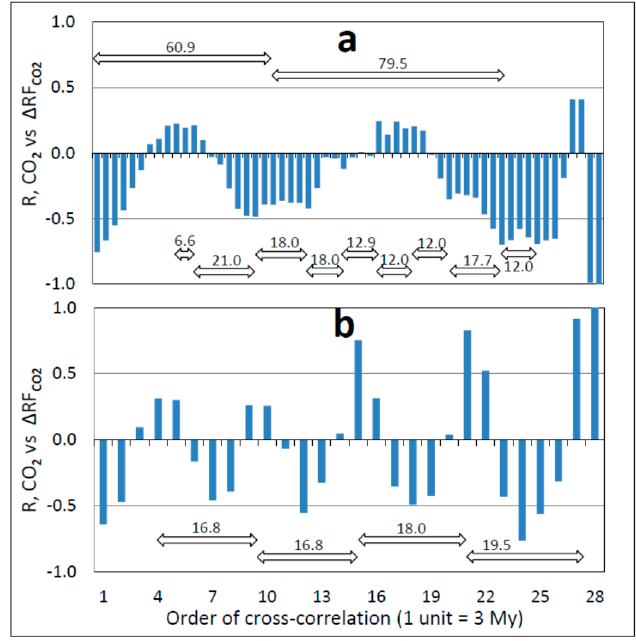
Figure 16. As in Figure 14, but for atmospheric CO 2 concentration and Δ RF CO2 . ( a ) Time period from 174 to 0 Mybp. Average short and long cycle durations, 14.5 and 70.2 My respectively. ( b ) Time period from 174 to 87 Mybp. Average short cycle duration, 17.8 My. The strong negative correlation coefficients at low shift orders demonstrate the antiphasic (inverse) relation between atmospheric CO 2 concentration and Δ RF CO 2 . Otherwise as in the legend of Figure 12.